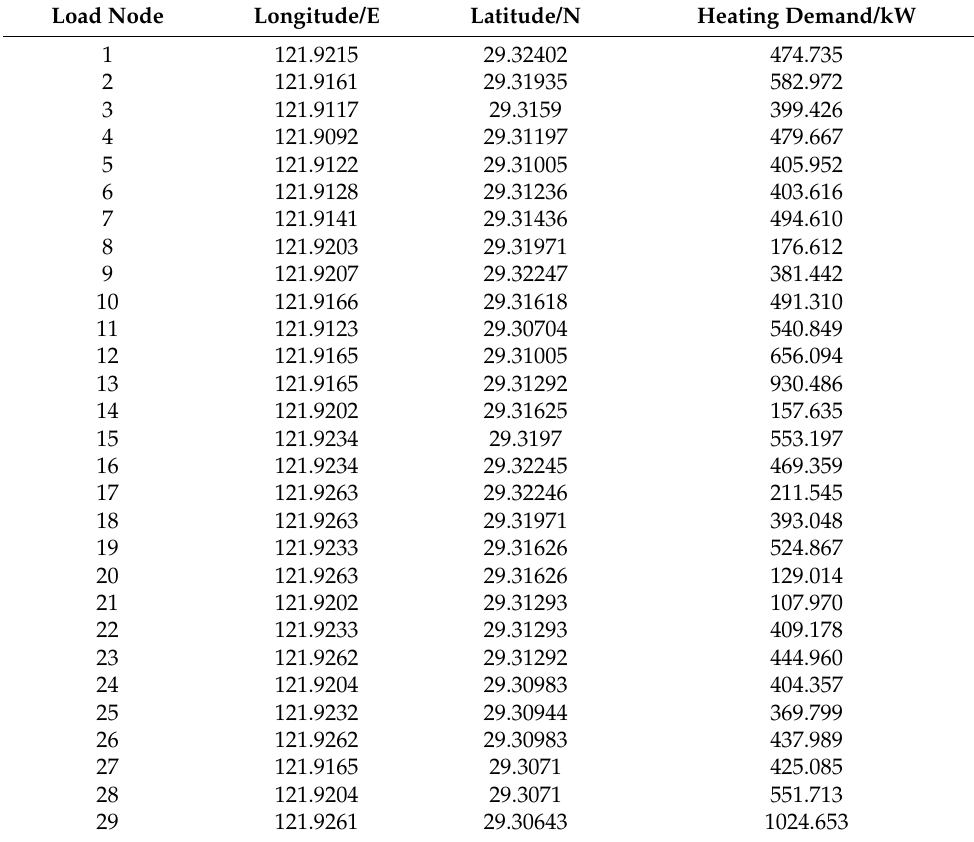
Table A1. Load information in the planning